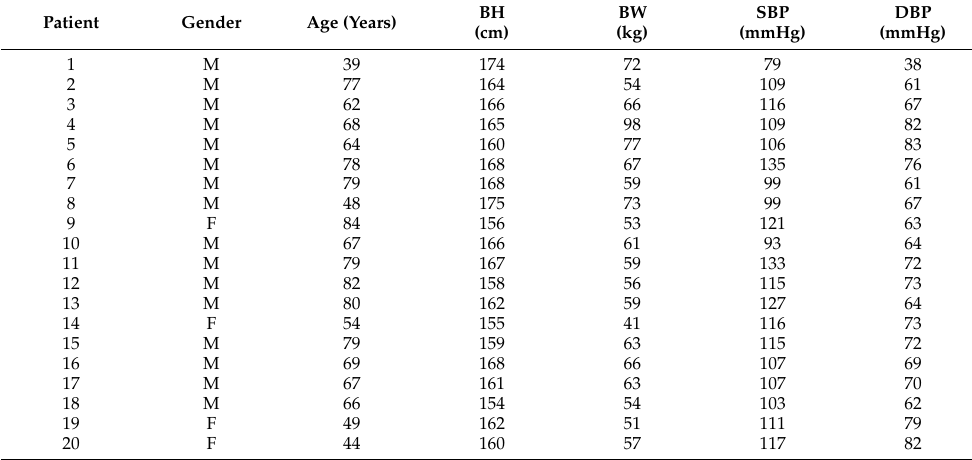
Table 4. The basic characteristics of twenty